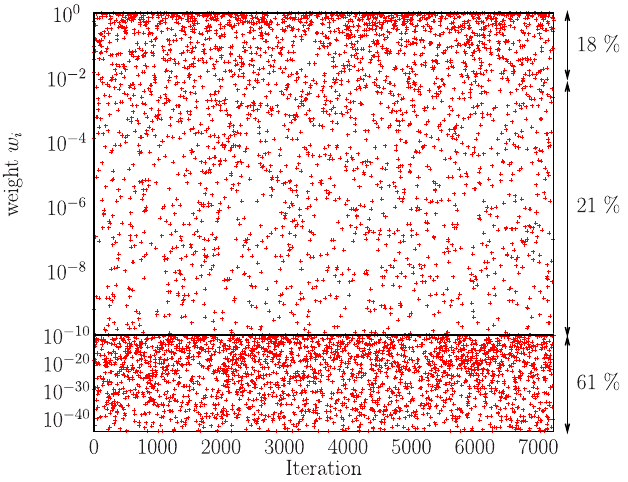
Fig. 1. Calculated weights w i for the 7000 random cases considered in this work. The number on the right are the percent of weights within the space de fi ned by the